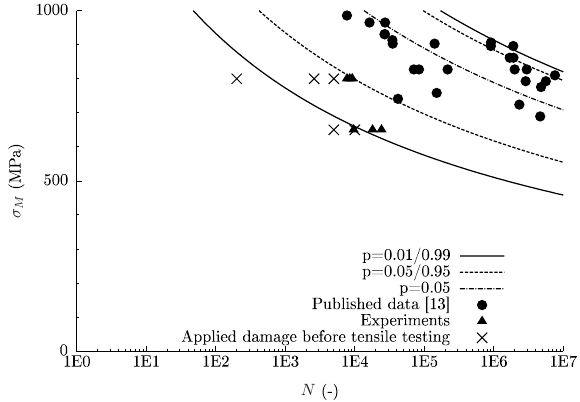
Fig. 4. Fatigue life of the samples used for cyclic loading and quasi-static tests and damage levels applied before tensile testing compared with published fatigue results